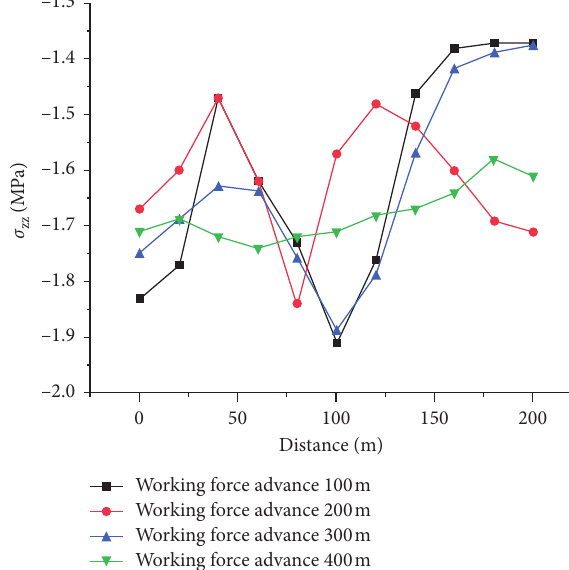
Figure 12: The vertical stress of monitoring points in the third left working face. Contour of XX–stress Calculated by: volumetric averaging